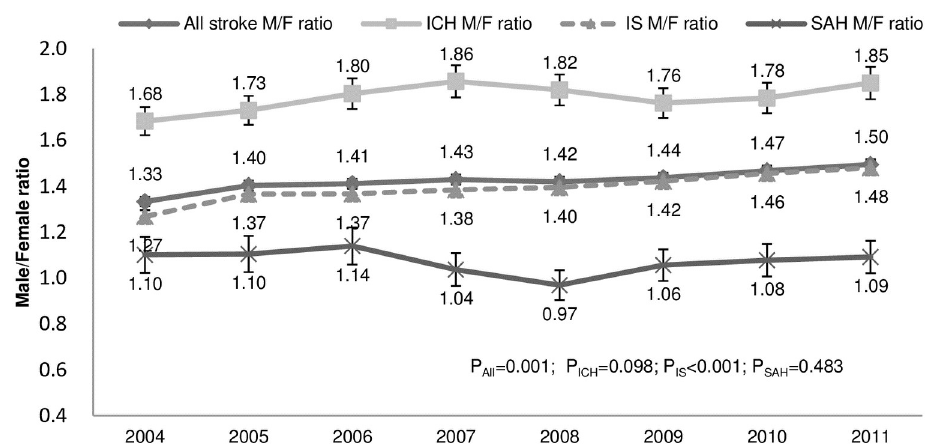
Fig 3. Changes in the male-to-female incidence ratio for all strokes and subtypes. M = male; F = female; ICH = intracerebral hemorrhage; IS = ischemic stroke; SAH = subarachnoid hemorrhage; P All = p for trend in all strokes; P ICH = p for trend in ICH; P IS = p for trend in ischemic stroke; P SAH = p for trend in subarachnoid